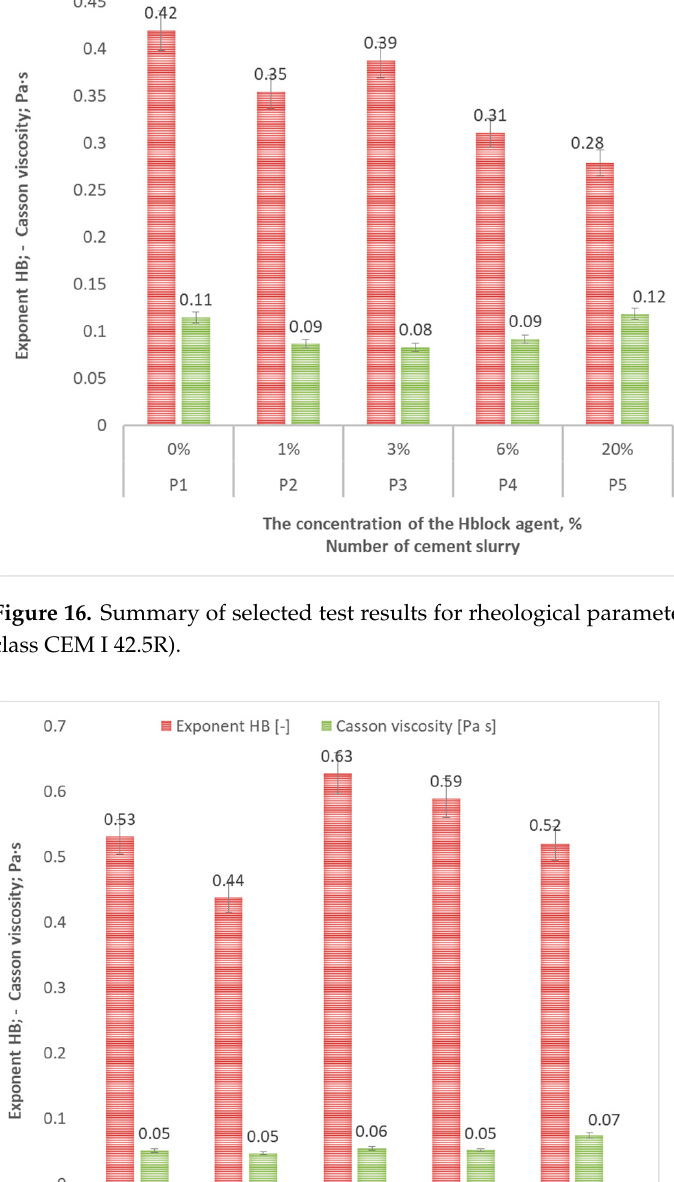
15 of 19 Figure 15. Summary of selected test results for rheological parameters of cement slurries (cement class CEM G). The P6 base slurry has a 1.9 Pa Herschel–Bulkley flow limit. The presence of Hblock results in an HB flow limit in the range of 2.75 Pa (sample P10) to 4.64 Pa (sample P7). The HB consistency coefficient ranges from 0.89 Pa·s n (sample P7 with 1% Hblock content) to 3.11 Pa·s n (sample P10 with 20% Hblock content). Casson viscosity of slurries prepared on the basis of CEM I 42.5R Portland cement ranges from 0.08 Pa·s (sample P3 with the addi ‐ tion of 6% Hblock) to 0.12 Pa·s (sample P5 with the addition of 20% Hblock) (Figure 16).